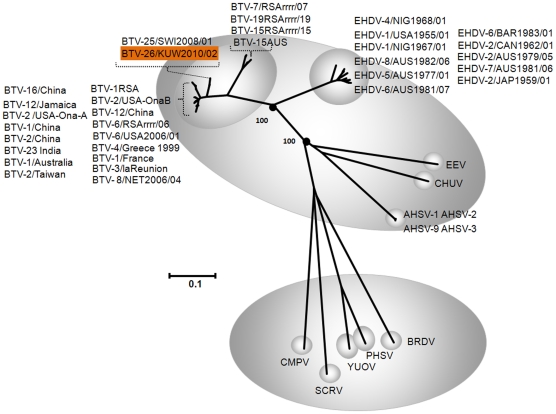
Neighbour-joining tree showing relationships between VP7[T13] from KUW2010/02 with other orbiviruses.KUW2010/02 showed between 69.2%/80.8% to 81.2%/97.7% nt/aa identity in Seg-7/VP7[T13] to other BTV isolates, confirming its identity as a member of the Bluetongue virus species. Accession numbers and further detail of the sequence and viruses used are included in Table 1. Epizootic haemorrhagic disease virus (EHDV), Bluetongue virus (BTV), Equine encephalosis virus (EEV), African horse sickness virus (AHSV), Chuzan virus (CHUV), St. Croix River virus (SCRV), Yunnan orbivirus (YUOV), Peruvian horsesickness virus (PHSV), Broadhaven virus (BRDV) and California mosquito pool virus (CMPV). Seg-7 accession numbers used for comparative analyses: AM745023, AM744983, AM745013, AM745063, AM745033, AM745043, AM745073, AM745003, AM744993, AM745053, AM745083, FJ183391, AY078469, FJ183371, HM035361, HM035392, AF545433, M87876, NC 007754, NC 007663, NC 006004, ACF22097, AY485667, AM498057, FJ437558, AY841352, GQ506542, GQ506502, AF172829, AF188660, X53740, AY493692, M63417, AJ277802, AF172826, AF172825, AF188674, AF188673, AF172831, EU839843, L11724, DQ465027, DQ465028, DQ465026.